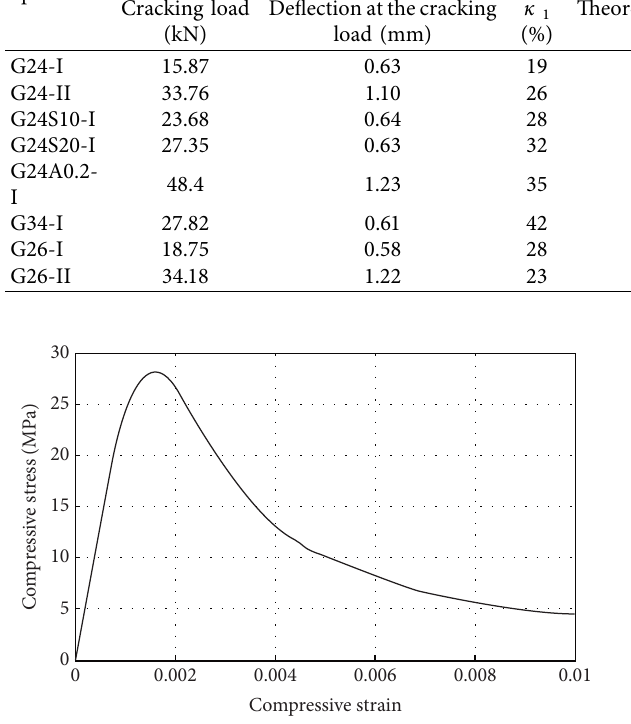
Figure 9: Compressive stress-strain curve of concrete.